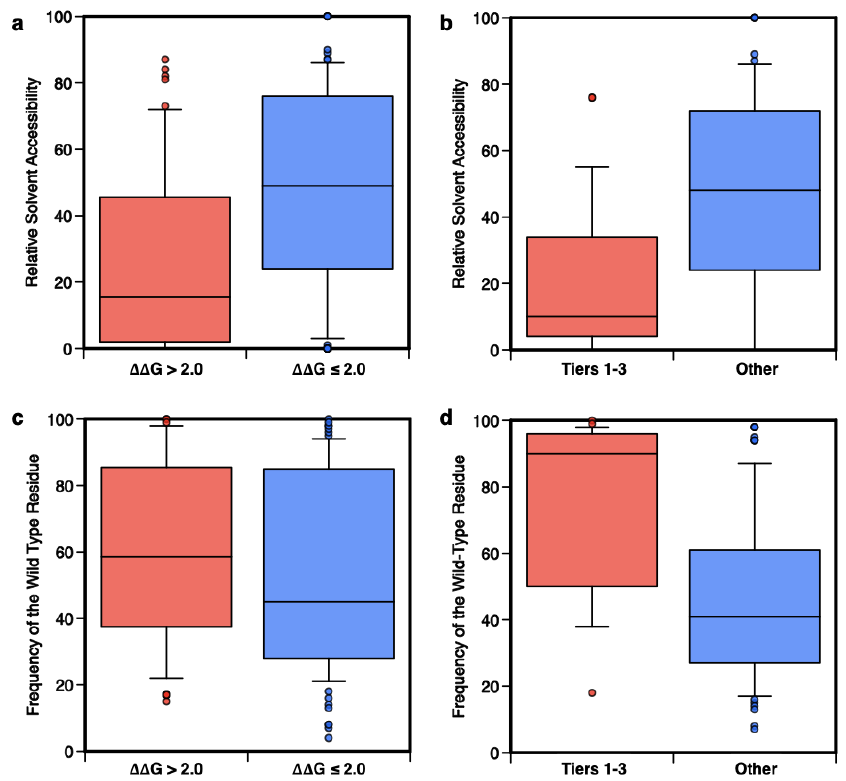
Figure 6. Distributions of the Relative Solvent Accessibility (RSA) and frequency of the wild-type residue ( f wt ) in the multiple sequences of homolog proteins. The distributions of RSA and f wt calculated for the subsets of 53 highly destabilizing variants ( ∆∆ G f > 2.0 kcal/mol) compared to the remaining 111 variants ( ∆∆ G f ≤ 2.0 kcal/mol) are shown in panels ( a , c ). In panels ( b , d ) the same distributions are plotted for the subsets of 24 putative cancer-driving (Tier 1–3) or 73 benign (‘Other’) variants.